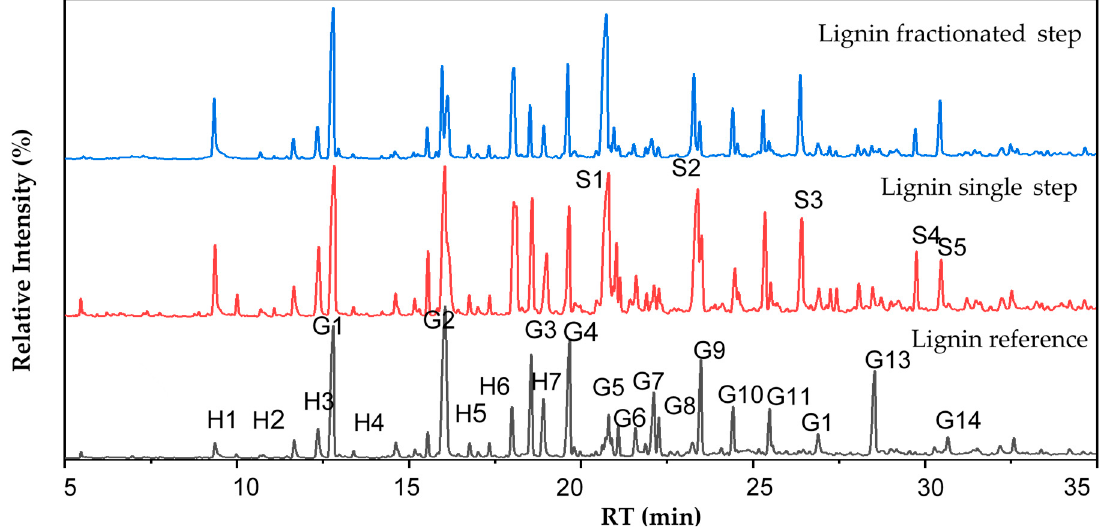
Figure 7. Pyrogram of single-step lignin and fractionated-step lignin compared to reference lignin. Table 3. The list of pyrolysis product reference lignin, single-step lignin, and fractionated-step lignin.